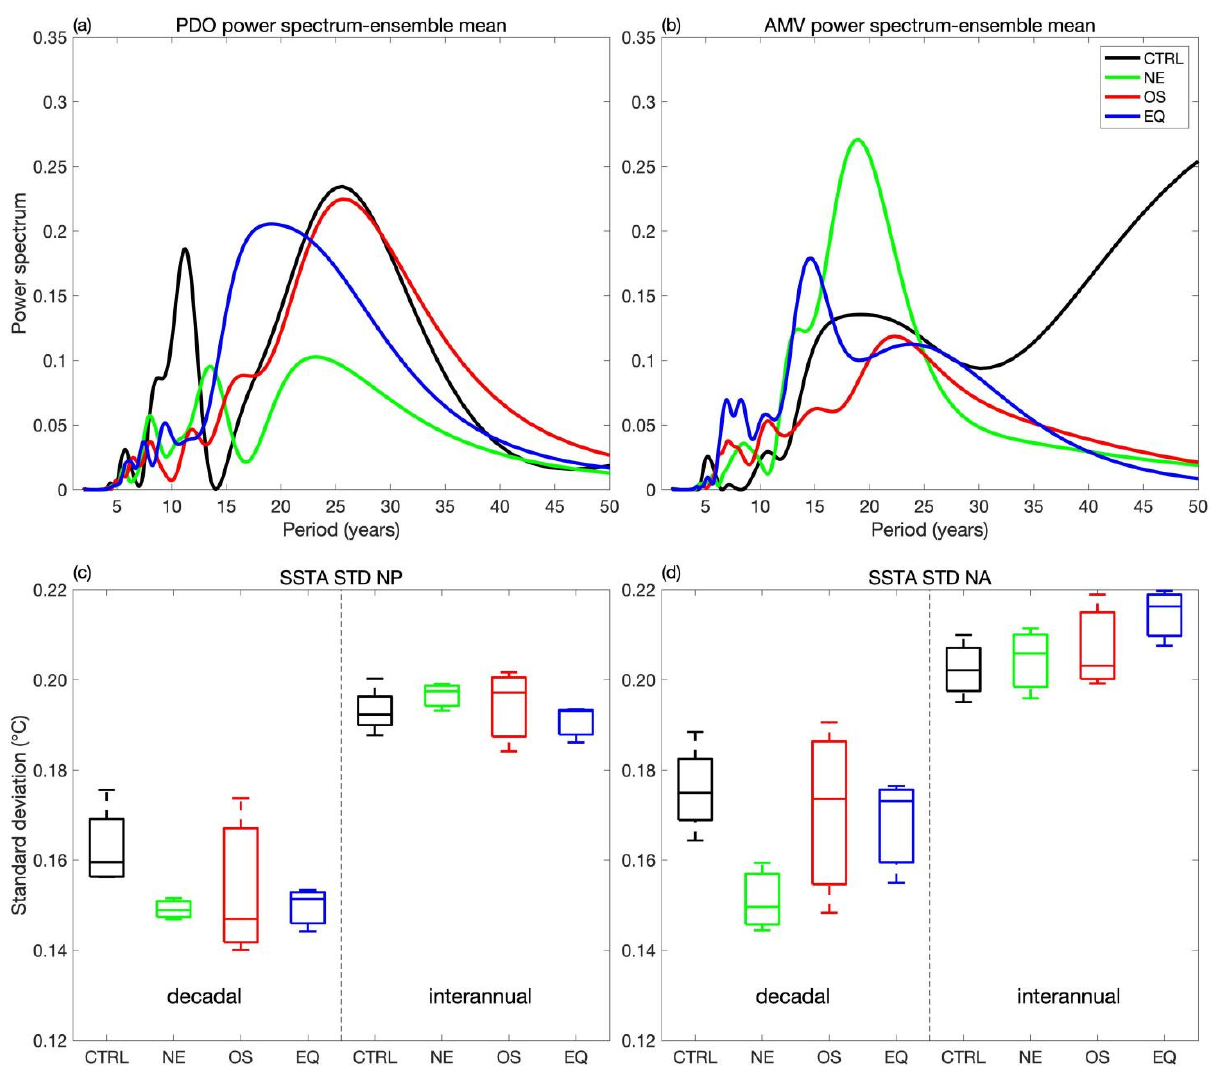
Figure 7. ( top ) Ensemble mean power spectra of ( a ) PDO and ( b ) AMV from the simulations of CTRL and three 1.5 ◦ C warming scenarios. ( bottom ) Distribution of the average of the ( c ) North Pacific and ( d ) North Atlantic SSTA standard deviation fields in CTRL, NE, OS, and EQ. “Decadal” and “interannual” mean decadal and interannual standard deviations, respectively. Boxplot boundaries are set at the 25th and 75th percentiles (p25 and p75, respectively).